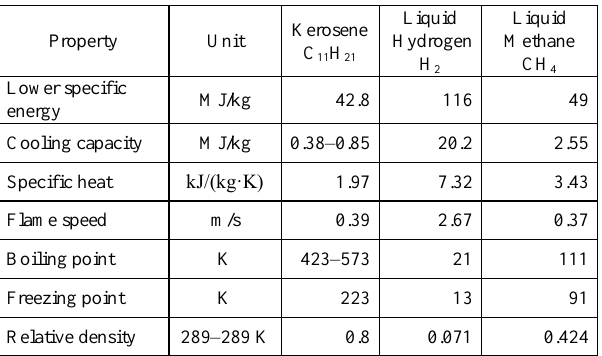
Table. 1. Properties of selected fuels [7]